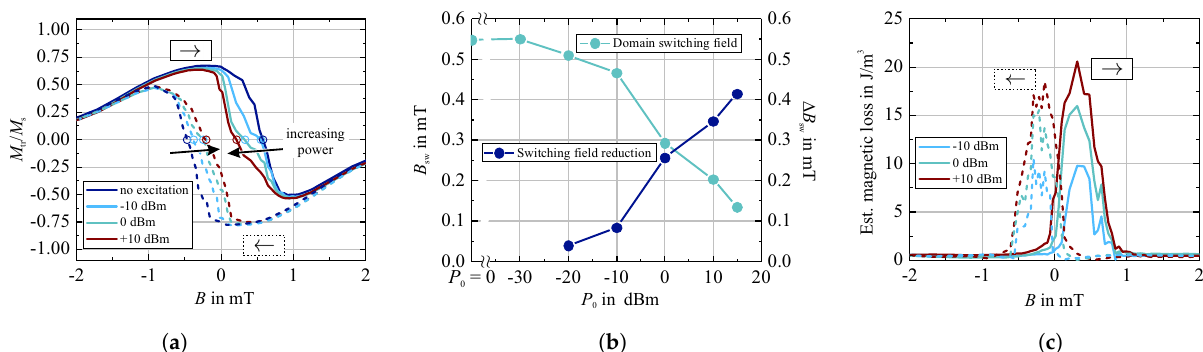
Figure 5. Exemplary transverse sensitivity magnetization loops for different values of electrical input power P 0 ( a ) and corresponding magnetic domain switching fields B sw and magnetic switching field reduction ∆ B sw with P 0 ( b ) derived from the transverse loops. The magnetic energy transfer ( c ) is estimated taking into account ( a ) and the easy axis magnetization characteristics (Figure 2). A static easy axis hysteresis loss of P dw ≈ 60J/m 3 is estimated from the easy axis loop. The varying electrical input power P 0 was set at or close to the synchronous frequency f 0 = 144.8MHz of the